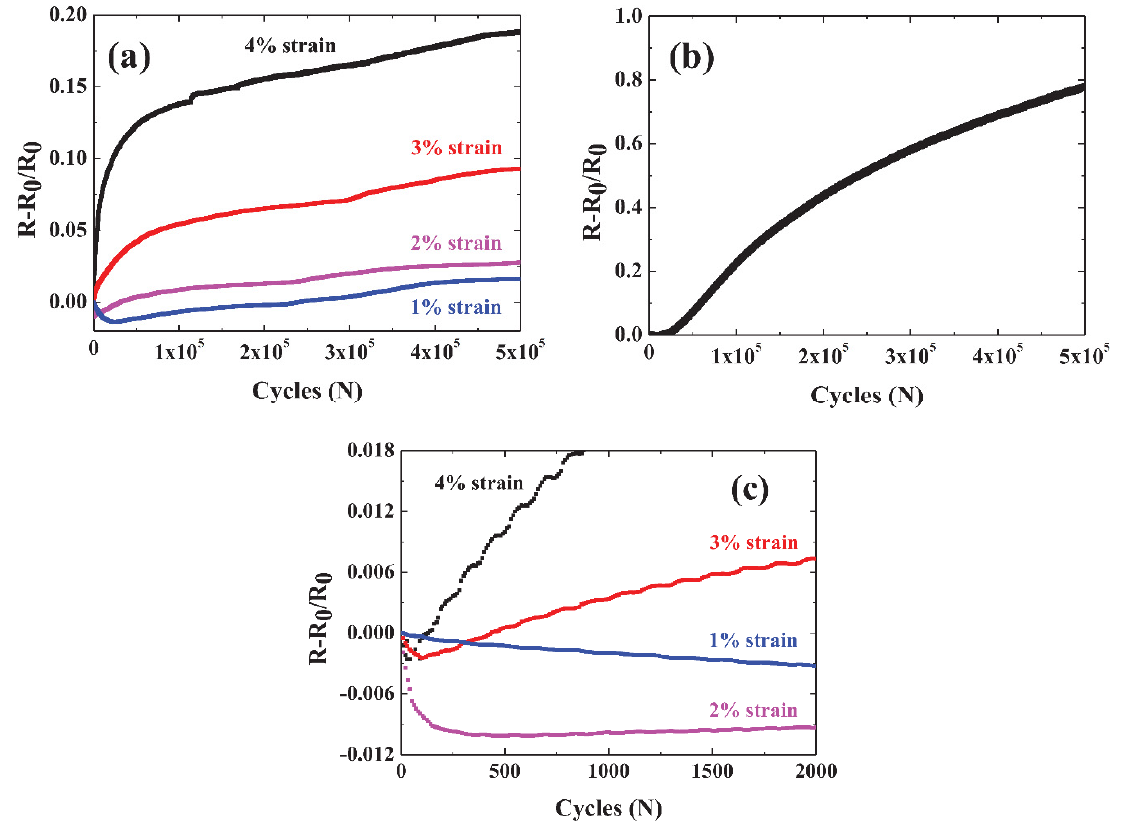
Figure 2. Resistance change over 500,000 bending cycles for ( a ) silver nanowire networks and ( b ) silver thin films with 1% strain, and ( c ) rescaled image ( a ) within 2000 cycles. Reproduced with permission from ref. [ 28] . Copyright 2014, Wiley.